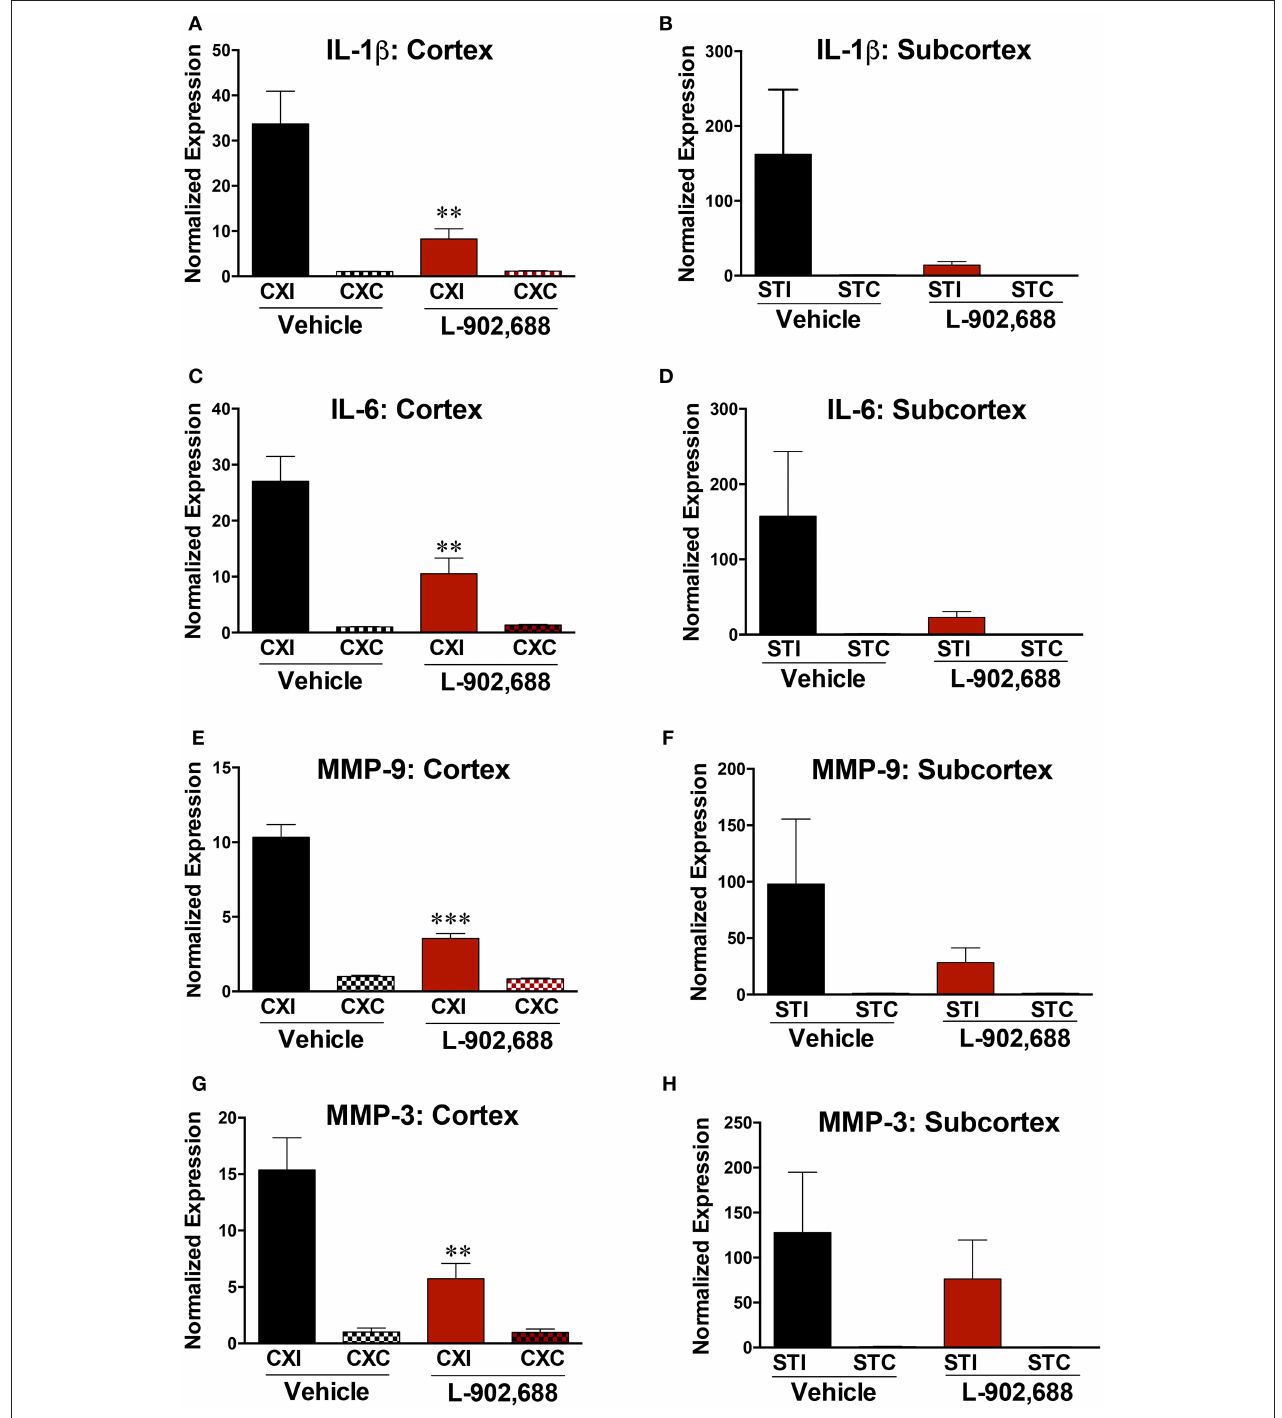
FIGURE 4 | Reduced IL-1 β , IL-6, MMP-9, and MMP-3 expression with L-902,688 treatment. (A ) IL-1 β is decreased in the ipsilateral cortex (** P = 0.0082) in rats given L-902,688. (B) There was a non-significant ( P = 0.0888), but substantial decrease in IL-1 β in the ipsilateral subcortex. (C) IL-6 is significantly downregulated in the ipsilateral cortex (** P = 0.0089) and slightly reduced in the subcortex (D) ( P = 0.1186) . (E) L-902,688 decreased MMP-9 in the ipsilateral cortex (*** P < 0.001) (F) There was a trend toward MMP-9 downregulation with treatment in the ipsilateral subcortex, but it did not reach significance ( P = 0.2335). (G) EP4 receptor activation with L-902,688 potently reduces MMP-3 mRNA expression in the ischemic cerebral cortex (** P = 0.0083). (H) No significant reduction in MMP-3 expression was found in the ischemic subcortical region between treatment groups ( P = 0.5104). Student’s t -test comparing vehicle and L-902,688 ipsilateral groups. CXI, ipsilateral cortex; CXC, contralateral cortex; STI, ipsilateral subcortex; STC, contralateral subcortex. Vehicle ( n = 10) and 1.0 mg/kg L-902,688 ( n = 8).